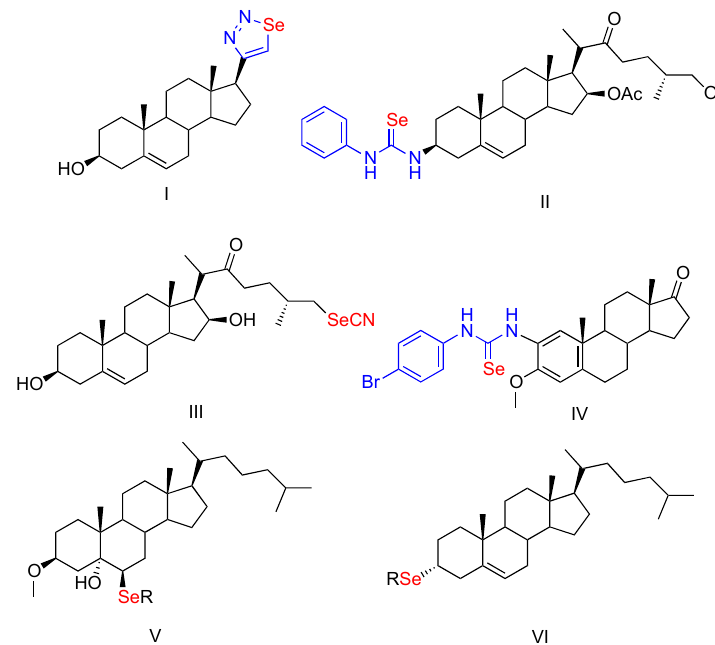
Figure 1. Some representative selenosteroids with antiproliferative and prooxidant activity. Selenium is directly bonded to the steroid (III, V and VI) selenium is imbedded in a different group (in blure) linked to the steroid (I, II, IV).